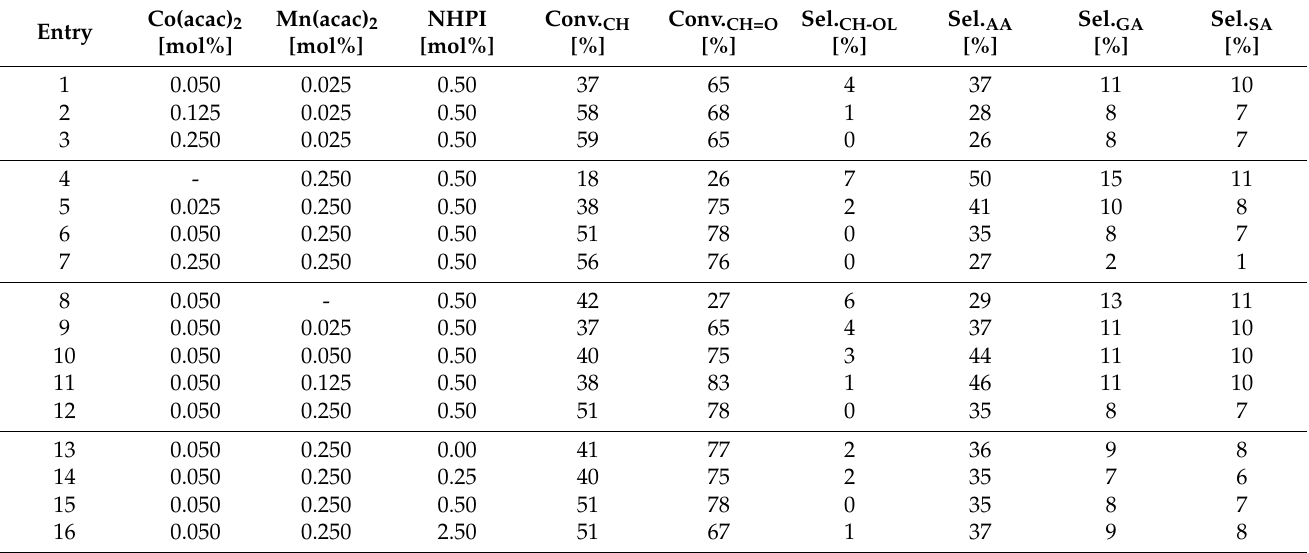
Table 2. The influence of the amount of Co(acac) 2 , Mn(acac) 2 and NHPI on the oxidation of CH/CH=O